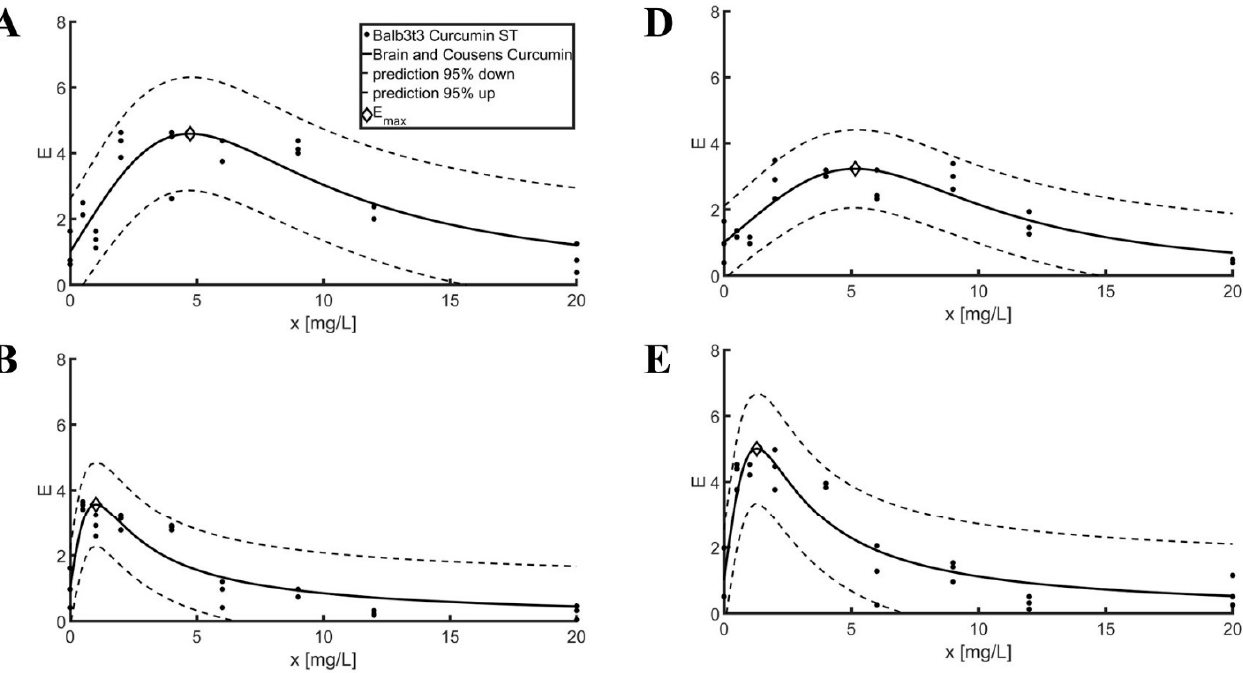
Figure 2. Brian and Cousens model curve adjustment for ST test. ( A ) Curcumin—Balb3t3; ( B ) Resveratrol—Balb3t3; ( C ) Baicalin—Balb3t3; ( D ) Curcumin—L929; ( E ) Resveratrol—L929; ( F ) Bai- calin—L929. Table 3. Estimated Brian and Cousens model parameters and values of maximum relative effects for ST tests.